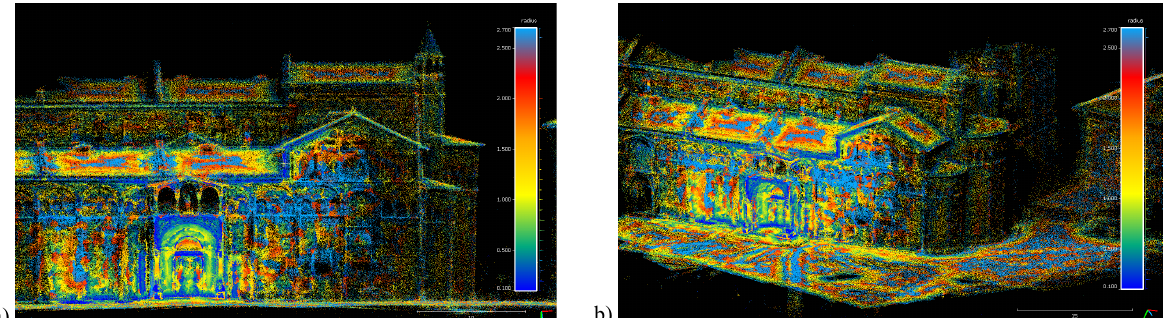
Figure 4: Some results of developed procedure for radii selection in the Modena case study. The twenty radii chosen for the feature extraction were identified in the range 0.1 - 2.7 meters. They correspond to the most frequent values which minimize the entropy of the points